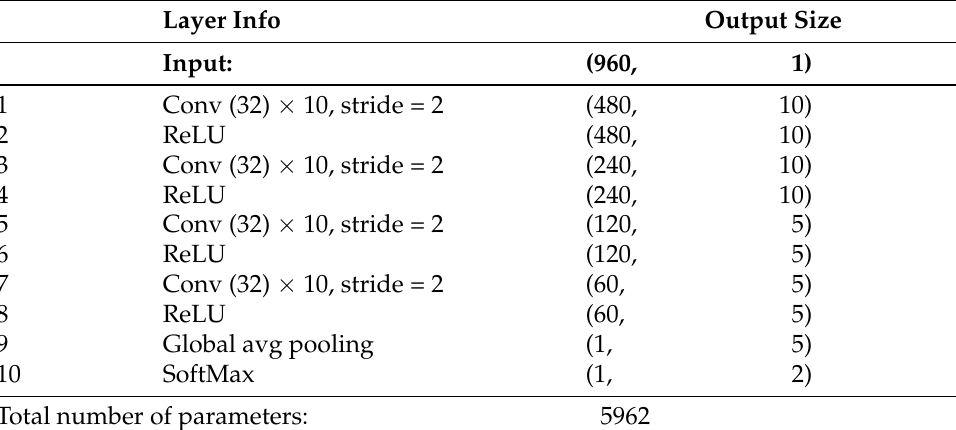
Table 3. Overview of the network architecture, e.g., Conv (32) × 10 indicates a convolutional layer of 10 filters of size